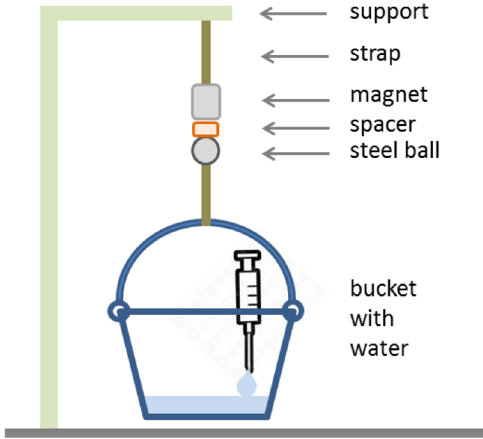
Fig. 9. Sketch of the apparatus used to determine experimen- tally the force between the magnet and a steel ball as a function of the separation. The amount of water was increased slowly and gently until the weight of the system bucket strap steel ball surpassed the magnetic interaction of the ball with the magnet. After each trial the weight was determined with a balance.